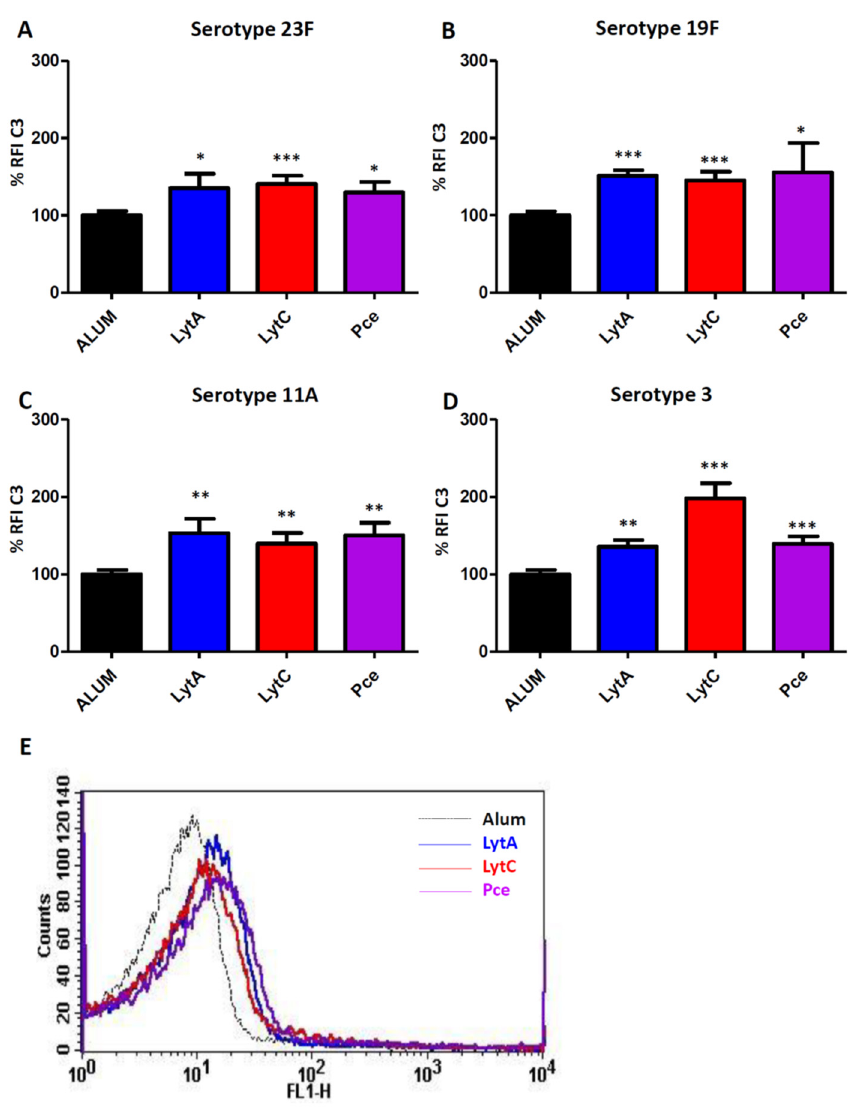
Figure 3. Recognition of different pneumococcal serotypes by C3 mediated by antibodies to LytA, LytC, or Pce. The different strains were exposed to pooled sera from mice immunized with Alum (black bar) or with LytA-Alum (blue bars), LytC-Alum (red bars), or Pce-Alum (purple bars). ( A ) Strain 48 (serotype 23F). ( B ) Strain 69 (serotype 19F). ( C ) Strain 450 (serotype 11A). ( D ) Strain 957 (serotype 3). ( E ) Example of a flow cytometry histogram for C1q deposition on the serotype 23F strain. Results are expressed as % RFI. Error bars represent the SDs and asterisks indicate statistical significance of LytA, LytC, or Pce immunization compared to the Alum group; * p < 0.05; ** p < 0.01; *** p < 0.001.